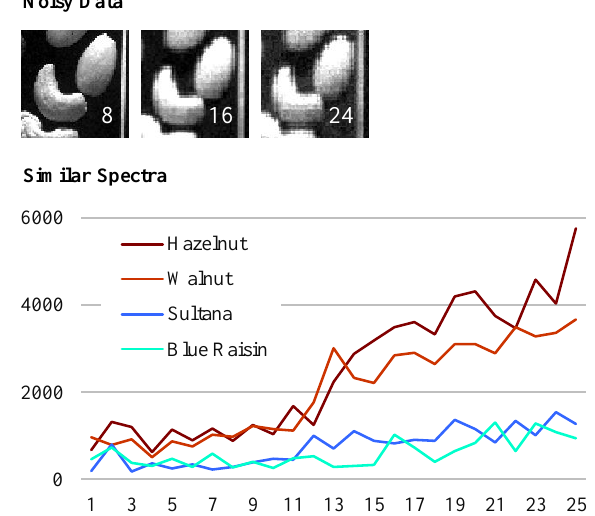
Figure 4. Noisy data and similar spectra as possible reasons leading to misclassification of the Cubert samples. The images showing the noisy data are labelled with their band number. The x-axis of the spectra graph refers to the band numbers and the y- axis to the corresponding reflectance values of a